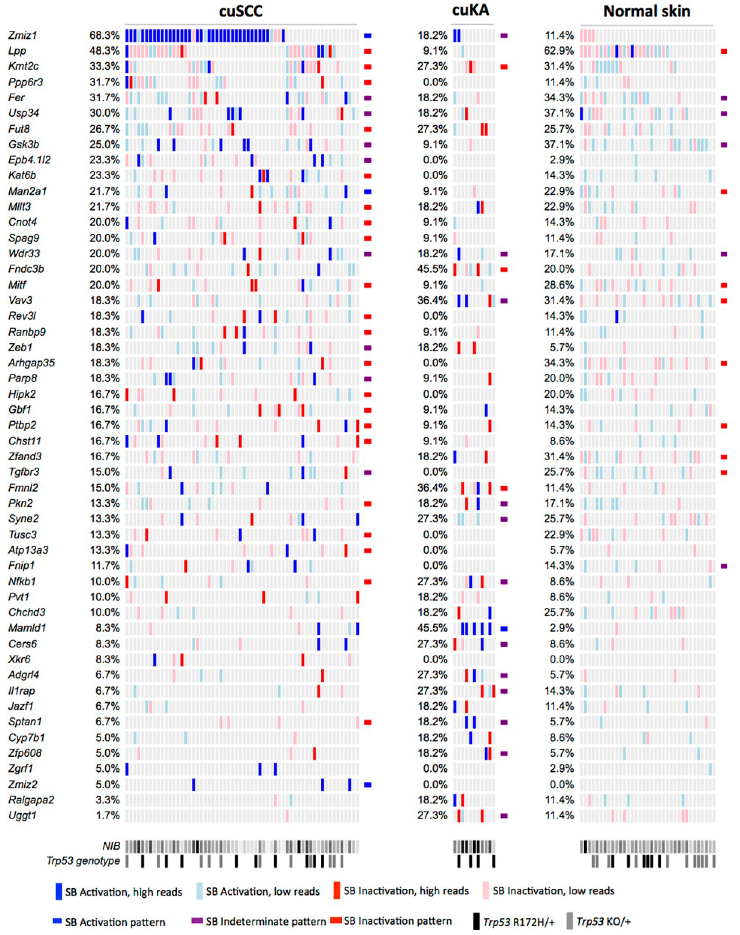
Fig 2. Landscape of trunk drivers mutated during SB-induced keratinocyte transformation and cuSCC progression using SBCapSeq. SB Trunk Driver Analysis, with read depth cutoff of 300, was performed using SBCapSeq insertion data from the SB|cuSCC and SB|cuKA tumor cohorts (the normal skin cohort did not identify any significant trunk drivers). Drivers with significant family-wise error rate (FWER) adjusted P -values were merged into a single list and plotted from each of the cuSCC, cuKA and normal skin specimens by occurrence within the cuSCC cohort. Vertical colored bars represent genomes (columns) with SB insertion events that occur within the same (sense, blue) or opposite (anti-sense, red) DNA strand relative to transcription of a driver gene (row). High read depth sites ( > 299 reads supporting an SB insertion event, blue or red) are distinguished from low read depth sites ( < 300 reads supporting an SB insertion event, light blue or pink) to denote clonal and sub-clonal SB insertion events, respectively ( S1, S2, and S3 Data ). Driver gene classifications (indeterminate, activating or Inactivating) are shown as a bar at the end of a gene on a cohort specific manner where calculation was possible. NIB, normalized insertion burden from highest (black) to lowest (light gray). Trp53 genotypes: Trp53 +/+ (white), Trp53 R172H/+ (black), and Trp53 KO/+ (gray).